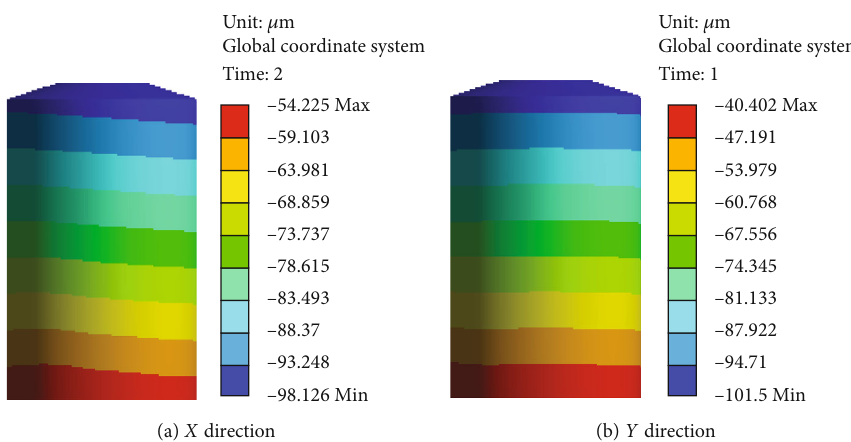
Figure 6: Displacement contours of motor component in X and Y directions with hydraulic eccentricity of 400 microns.